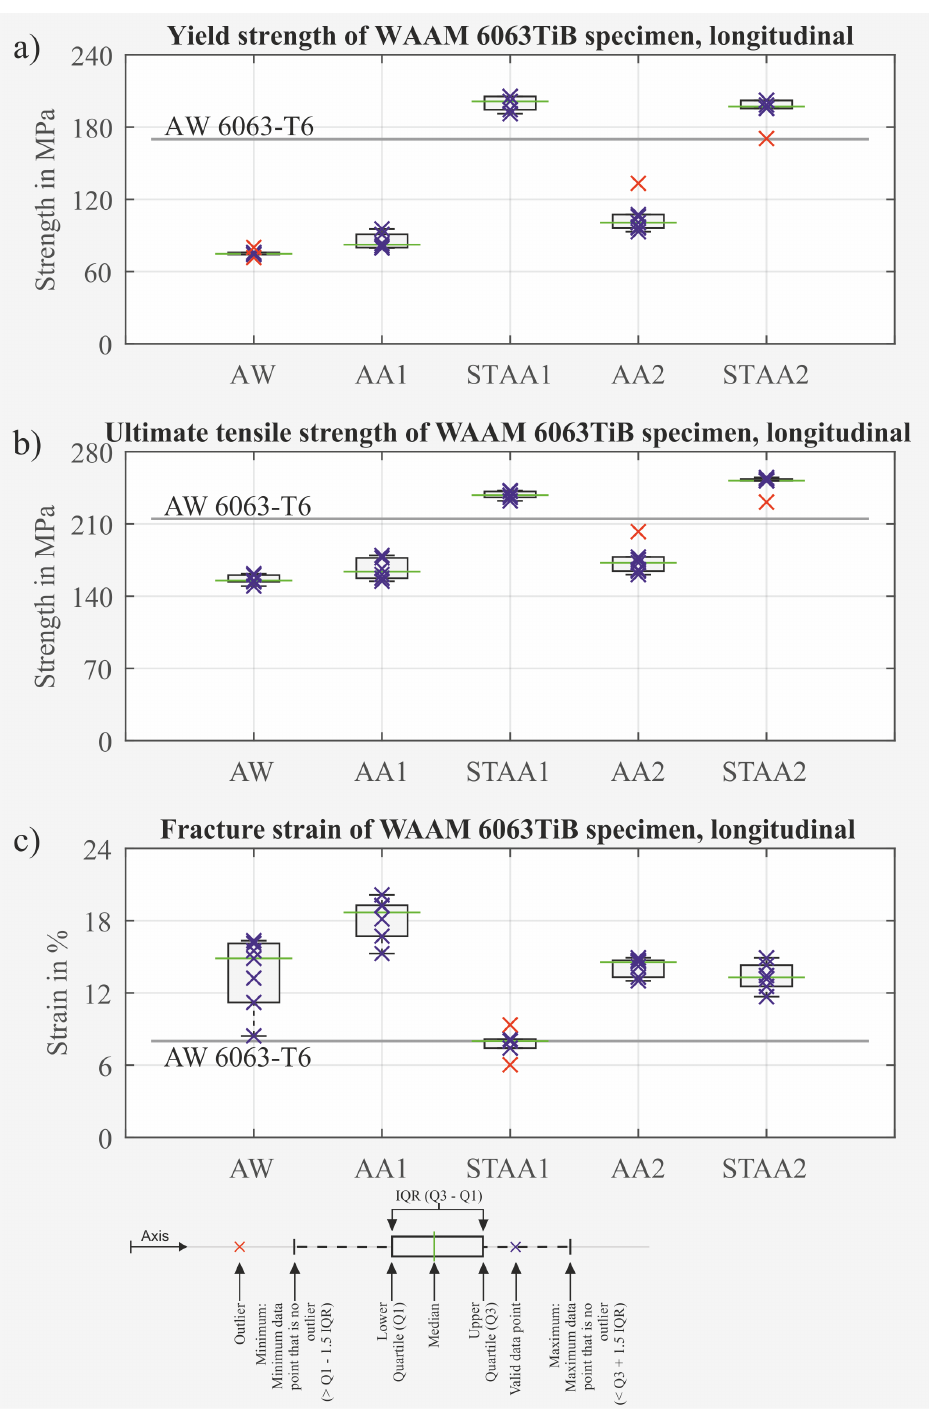
Figure 7. The strength properties of longitudinal WAAM AW 6063TiB specimens for different PWHT strategies ( a ) yield strength, ( b ) ultimate tensile strength and ( c ) fracture